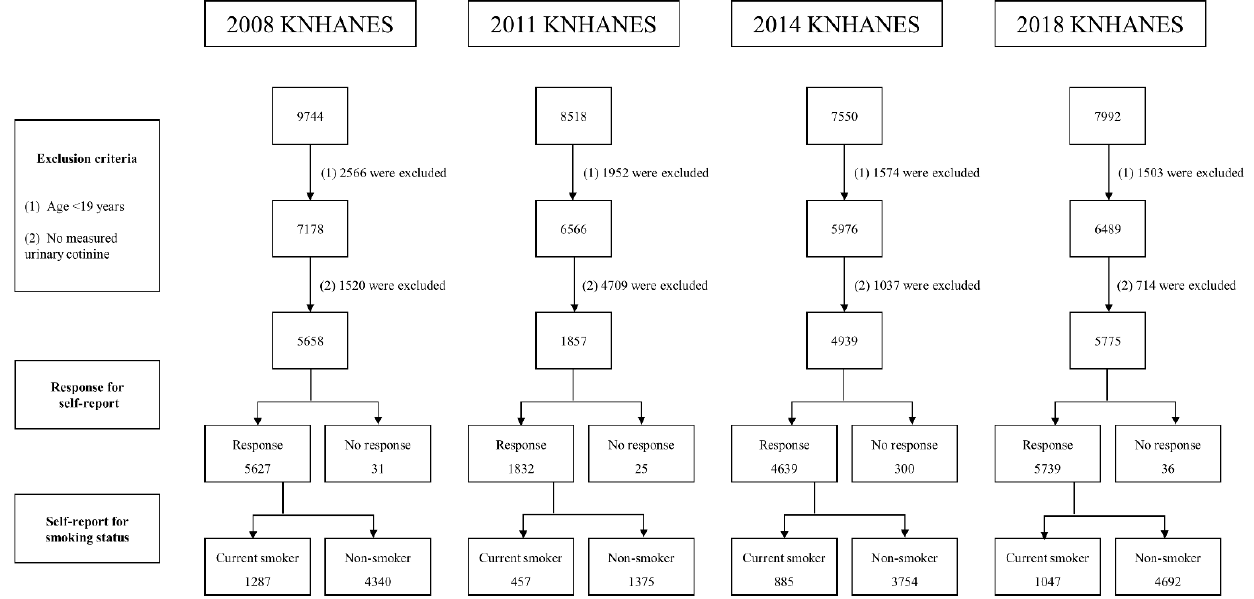
Figure 1. Schematic flow chart of study design and exclusion criteria in the current study.